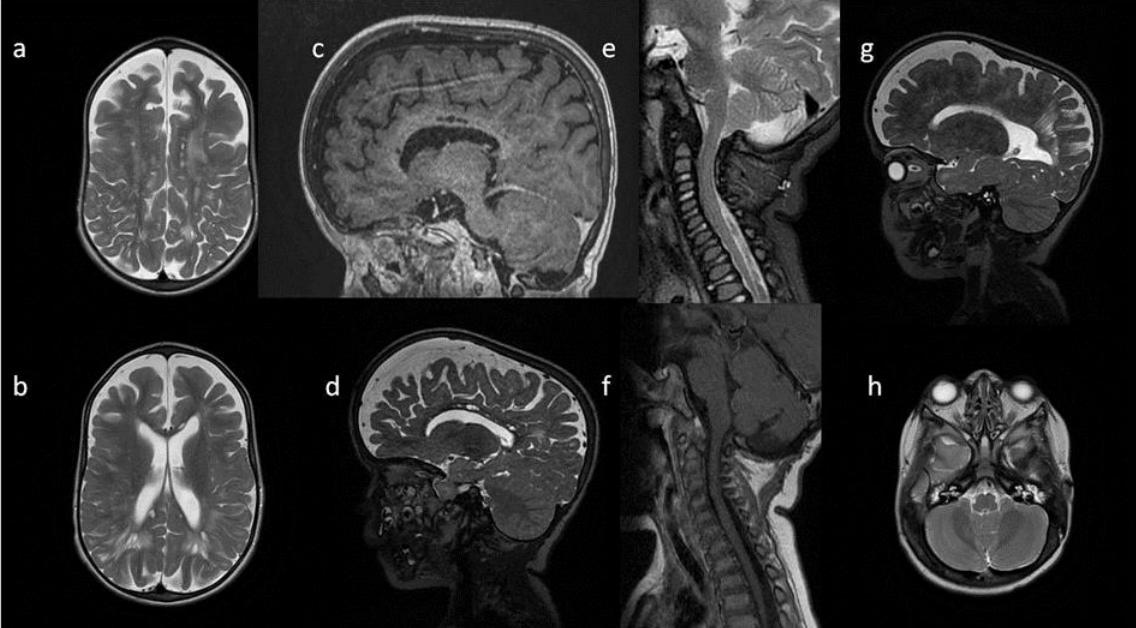
Figure 4. Brain MRI. Patient 4, 1st exam. ( a – d ) axial T1 & T2; ( e – h ) sagittal T1, T2, Flair T2, T1. Findings: ( a , c , g ) enlarged periventricular spaces with characteristic location in corpus callosum; ( a , c , g ) abnormal white matter signals; ( b ) posterior fossa horns, mastoid cells fluid; ( d ) optic nerve sheath enlargement, ethmoid sinus fluid; ( e , f , h ) J-shaped sella turcica, dysplastic dens; ( e , g ) skull deformation.